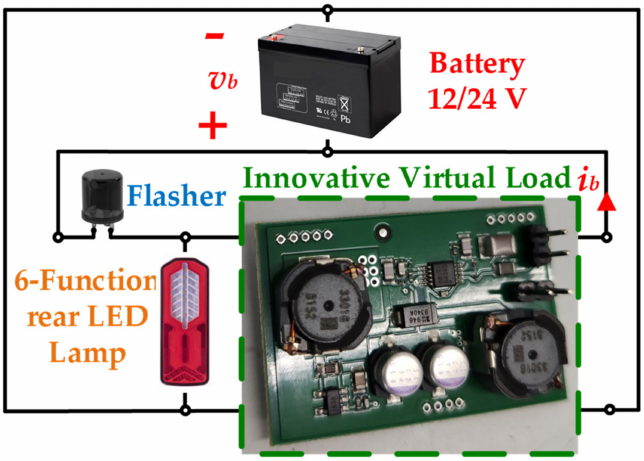
Figure 6. Industrial prototype of the innovative energy recovery unit, incorporated in the 6-Function rear LED lamp model of Dasteri Systems